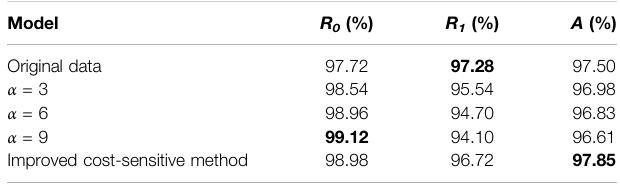
TABLE 2 | Evaluation results of different models.